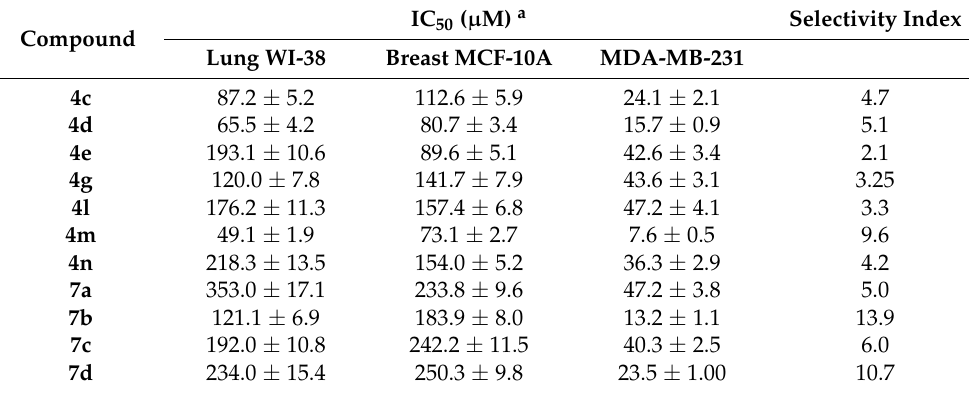
Table 2. In vitro cytotoxic activity against nontumorigenic cell lines (WI-38 and MCF-10A), and selectivity index (MCF-10A/ MDA-MB-231) for the active